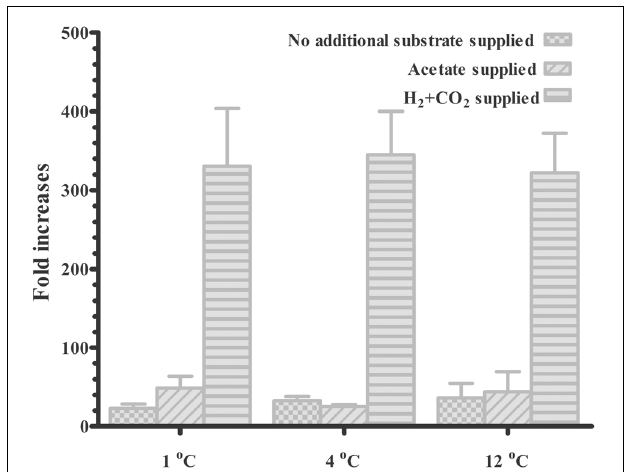
FIGURE 4 | Increase in mcrA gene copy number in subglacial sediment after incubation for 7 months. The mcrA gene copy number in the original sediment was 2.3 × 10 4 copy/g sediment according to the q-PCR results. (mean ± SEM,